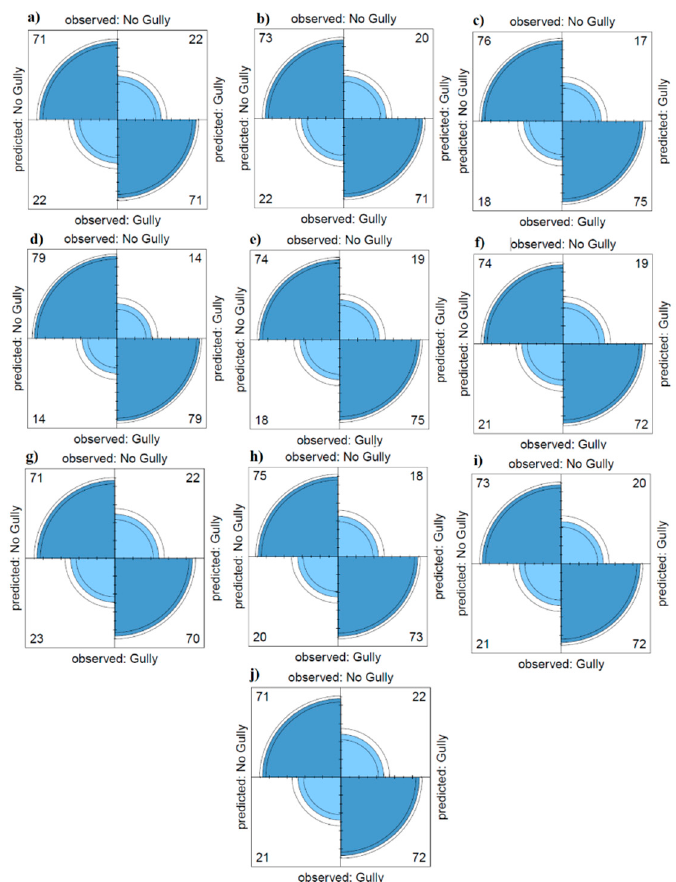
Figure 9. Values of true negative (TN), false positive (FP), true positive (TP) and false negative (FN) for each individual or ensemble model. ( a ) FR, ( b ) SI, ( c ) RF, ( d ) ME, ( e ) GLM, ( f ) FDA, ( g ) TOPSIS, ( h ) GLM–FDA, ( i ) FR–RF, ( j ) SI–RF.